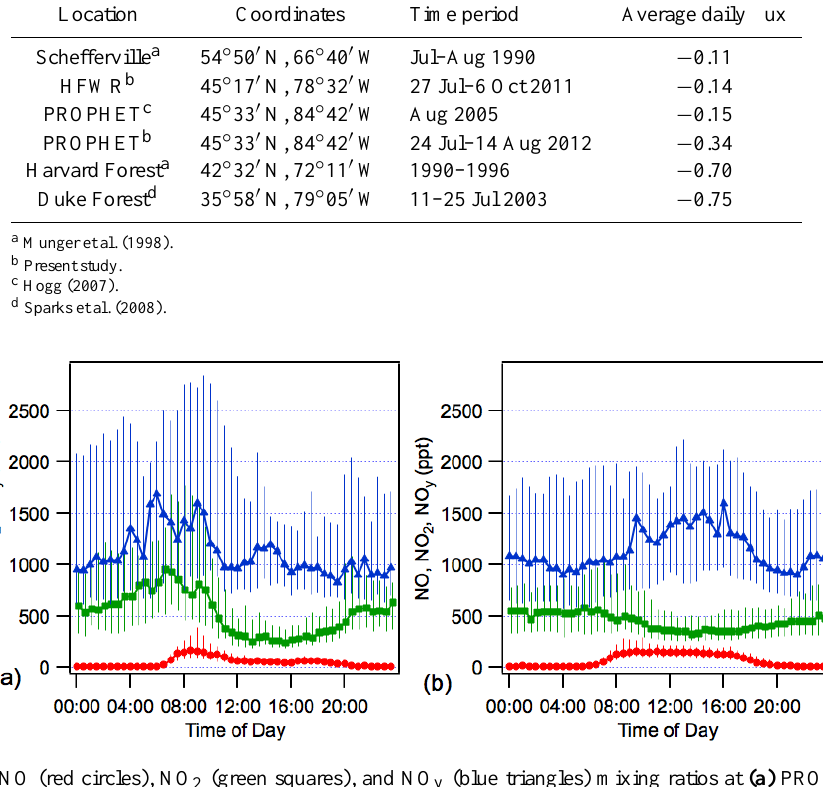
Fig. 6. Diurnal average NO (red circles), NO 2 (green squares), and NO y (blue triangles) mixing ratios at (a) PROPHET and (B) HFWR. Lines with markers indicate the median, and vertical lines denote the middle 50% distribution of the